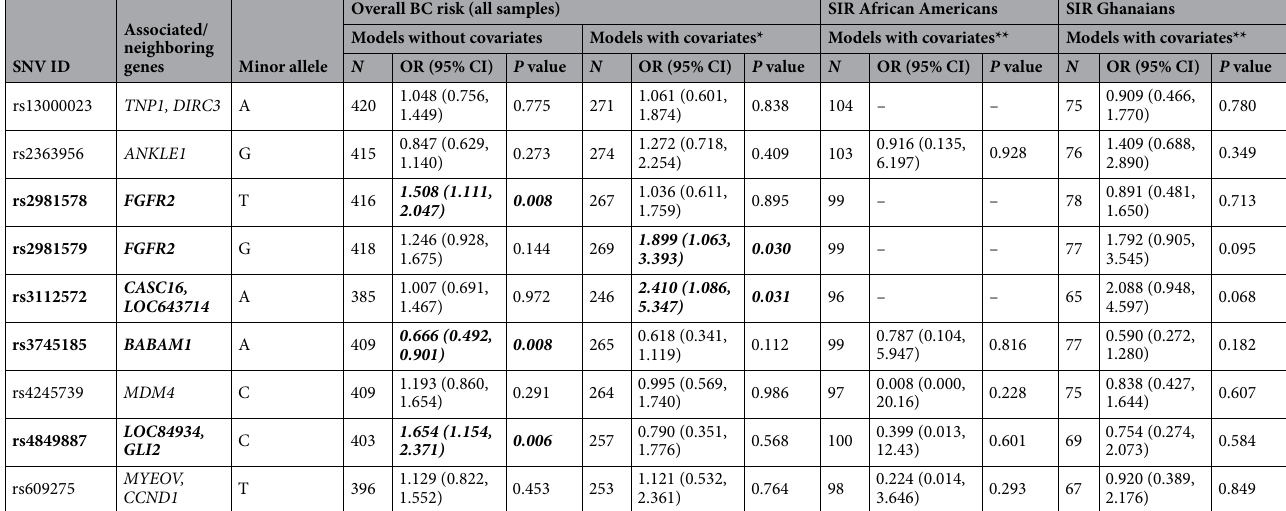
Table 2. Breast cancer risk assessment (case–control) of previously identified variant alleles. Significant alleles ( p value < 0.05) are given in bold and italic *Overall analysis models with covariates adjusts for age and SIR. **SIR models with covariates adjusts for